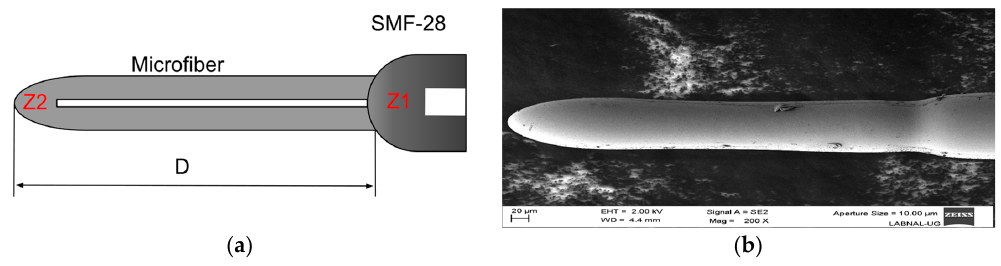
Figure 1. Physical characteristics of the MFI structure: ( a ) structure diagram; ( b ) Scanning Electron Microscope Image (SEM) of the structure.